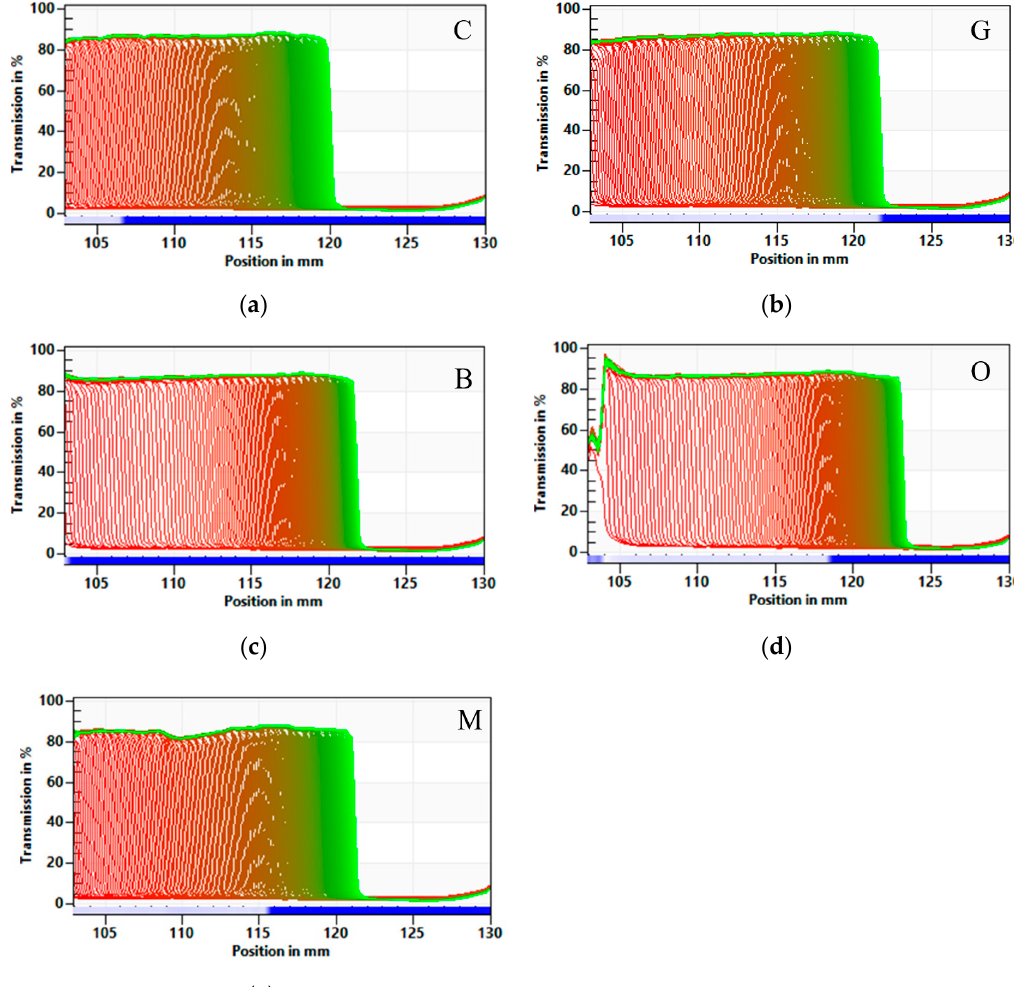
Figure 6. Influence of different tea infusion on the yoghurt transmission profiles presented enabling LUMiSizer ® analysis. ( a ) C—Control, ( b ) G—Green tea, ( c ) B—Black tea, ( d ) O—Oolong tea, ( e ) M—Lemon balm.